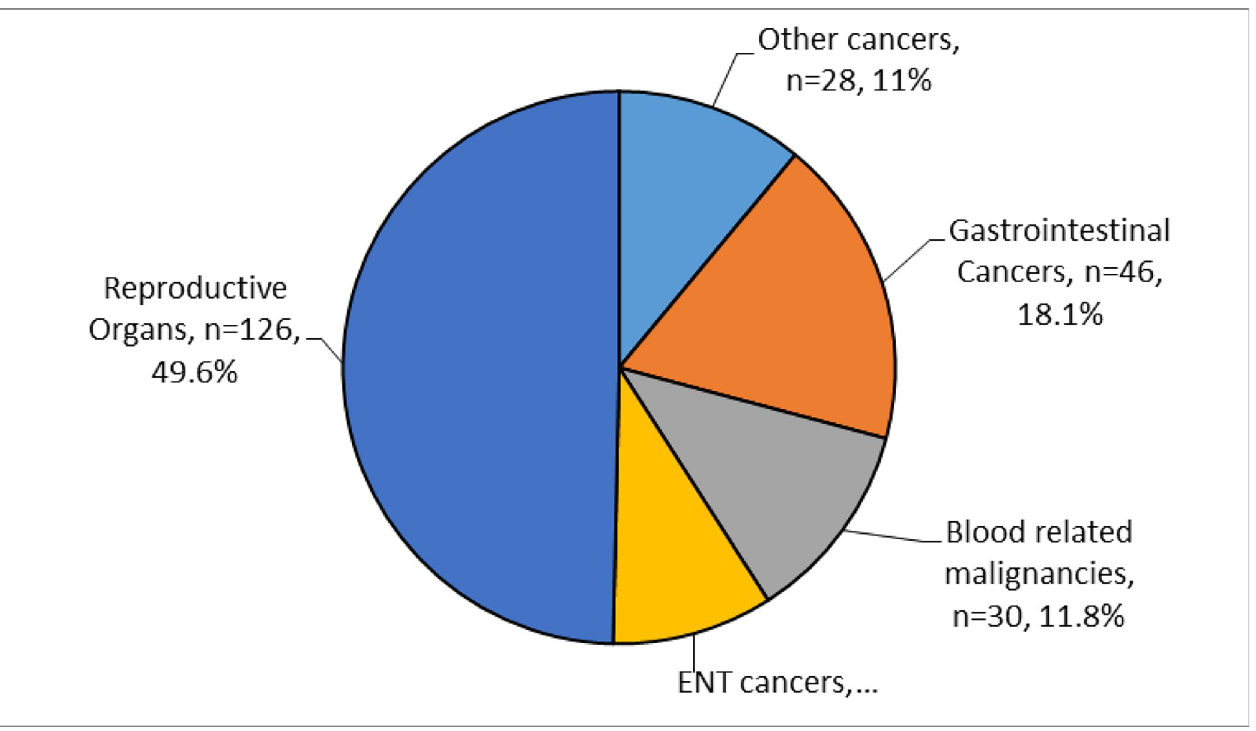
Fig 1. Types of cancers in categories.